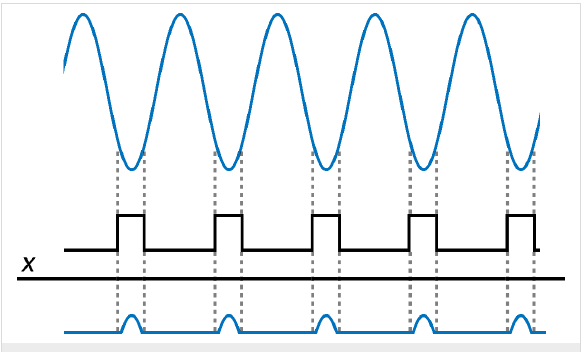
Figure 4: Illustration of the derivation of the indentation. The upper blue line represents the tip–sample distance. Multiplying that function with a square pulse function (black line) with duty cycle equal to the contact time, and changing sign, yields the indentation, represented by the lower blue